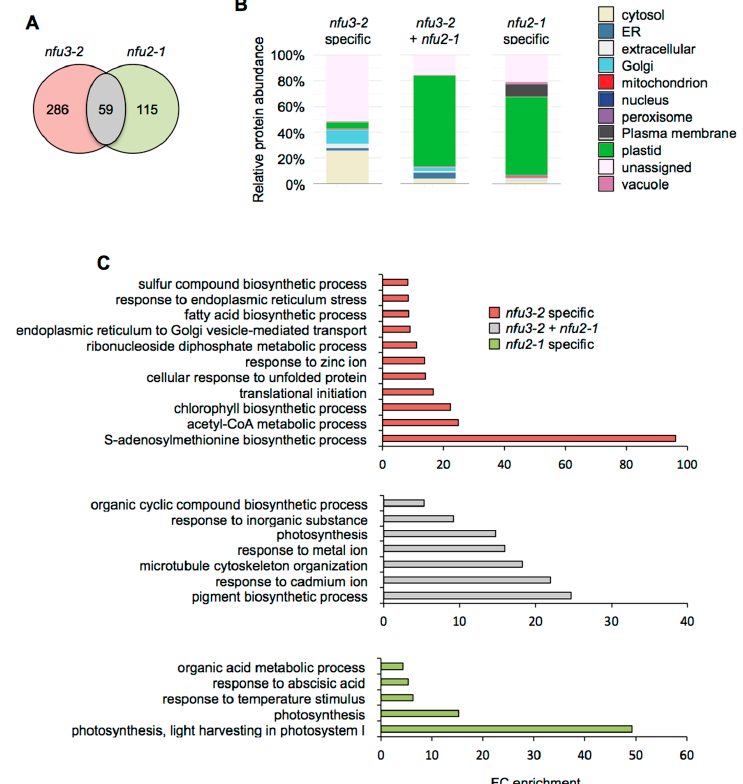
Figure 4. Comparison of proteins whose abundance is decreased in the Arabidopsis thaliana nfu3-2 and nfu2-1 mutants when compared to the wild type. Venn diagram comparing the proteins whose abundance is decreased in both nfu3-2 and nfu2-1 mutants (whole seedlings). Seedlings were grown as described in [21]. Venn diagram was done with Venny 2.1 (https: // bioinfogp.cnb.csic.es / tools / venny / index.html) ( A ). Subcellular localization of proteins whose abundance is decreased in both nfu3-2 and nfu2-1 mutants. Protein localization was analyzed in silico using the multiple marker abundance profiling method of the SUBA4 bioinformatic platform (http: // suba.live / ) ( B ). Gene ontology (GO) analysis of proteins whose abundance is decreased in both nfu3-2 and nfu2-1 mutants. GO term enrichment analysis was conducted using the PANTHER gene ontology platform (http: // go.pantherdb.org). Significant GO term enrichment was determined using Fisher exact test with Bonferroni correction ( C